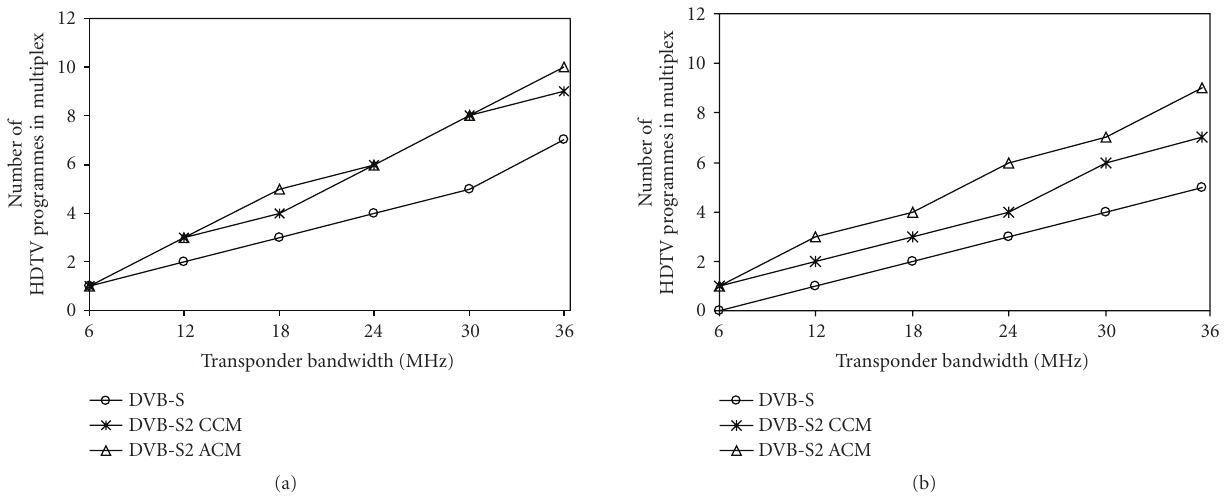
Figure 8: (a) Number of HDTV programmes in the multiplex—Greece scenario. (b) Number of HDTV programmes in the multiplex— Indonesia